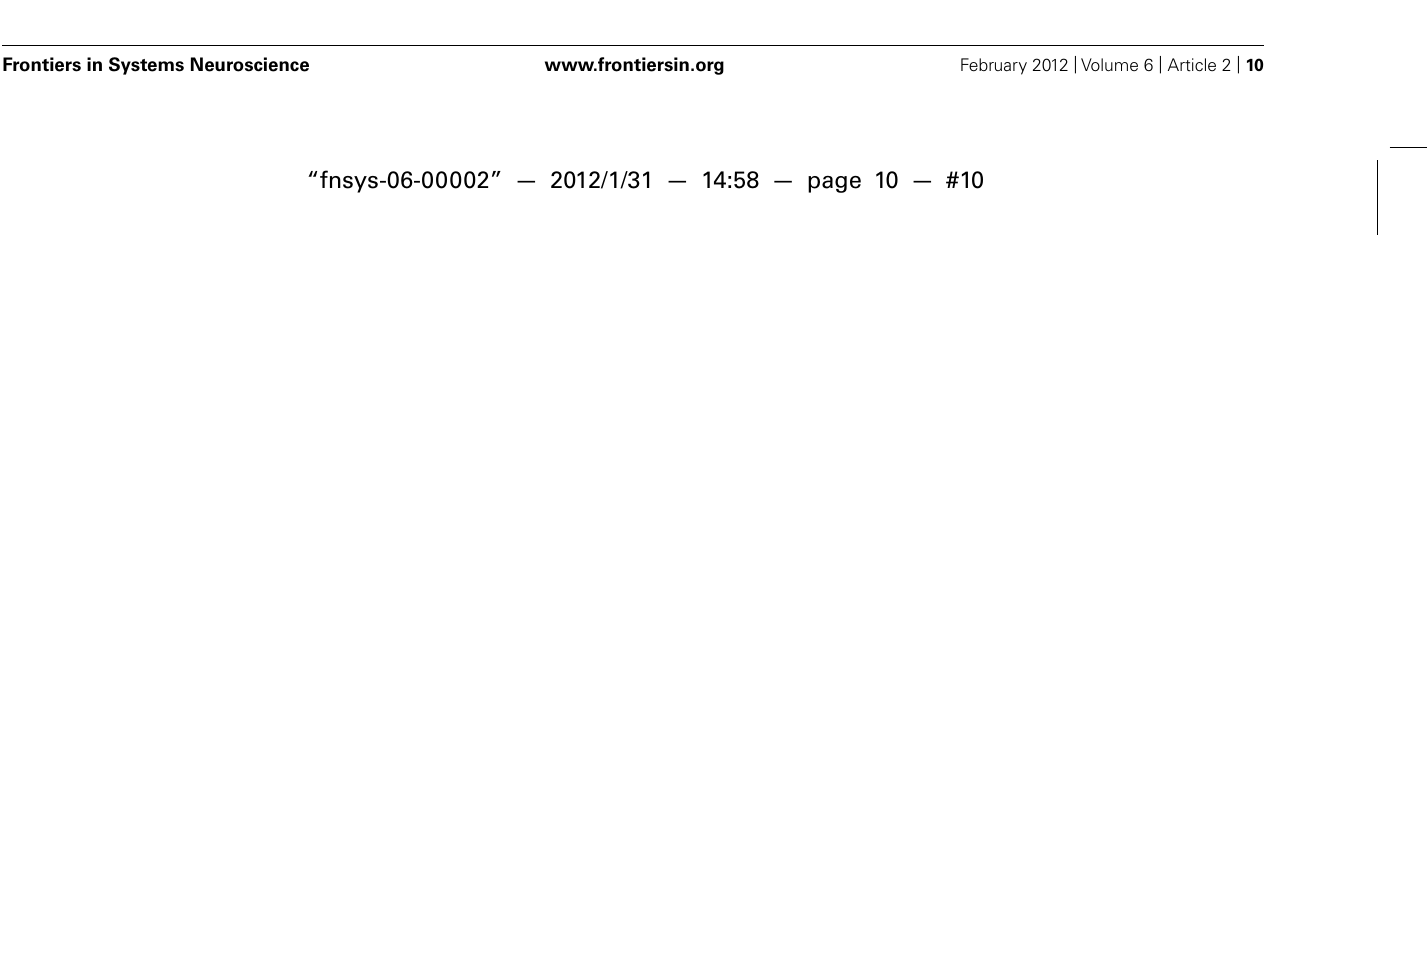
FIGURE 5 | (A) Individual spatial response maps of the second principal component x 2 for all subjects in the two groups, arranged in order of decreasing similarity with the mean map of all subjects (as quantified by Pearson correlations R ). (B) The detailed but complex representations in (A) were projected onto a two-dimensional feature space that still captured a maximal amount of variance by means of principal component analysis.